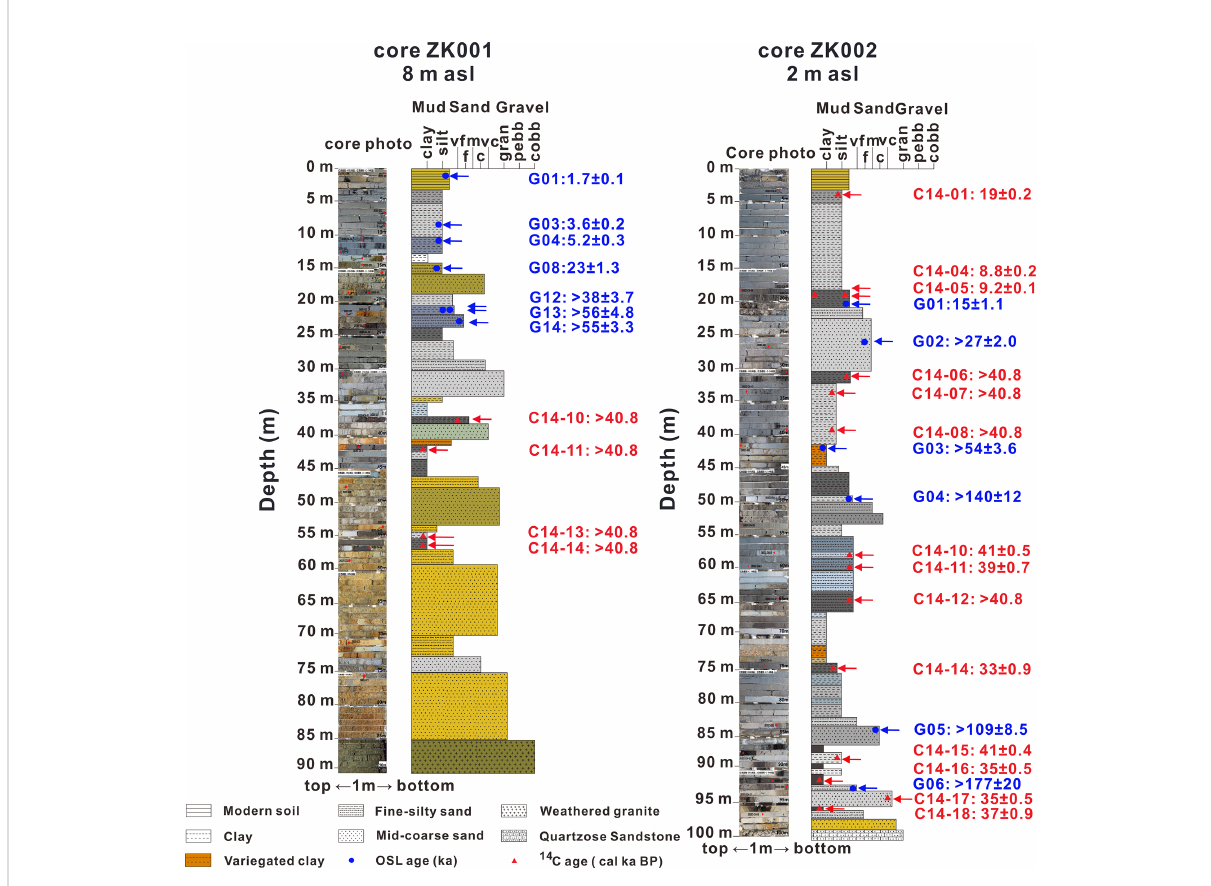
FIGURE 4 Pro fi les and ages of cores ZK001and ZK002. The red triangle represents the 14 C age; blue circle represents the OSL